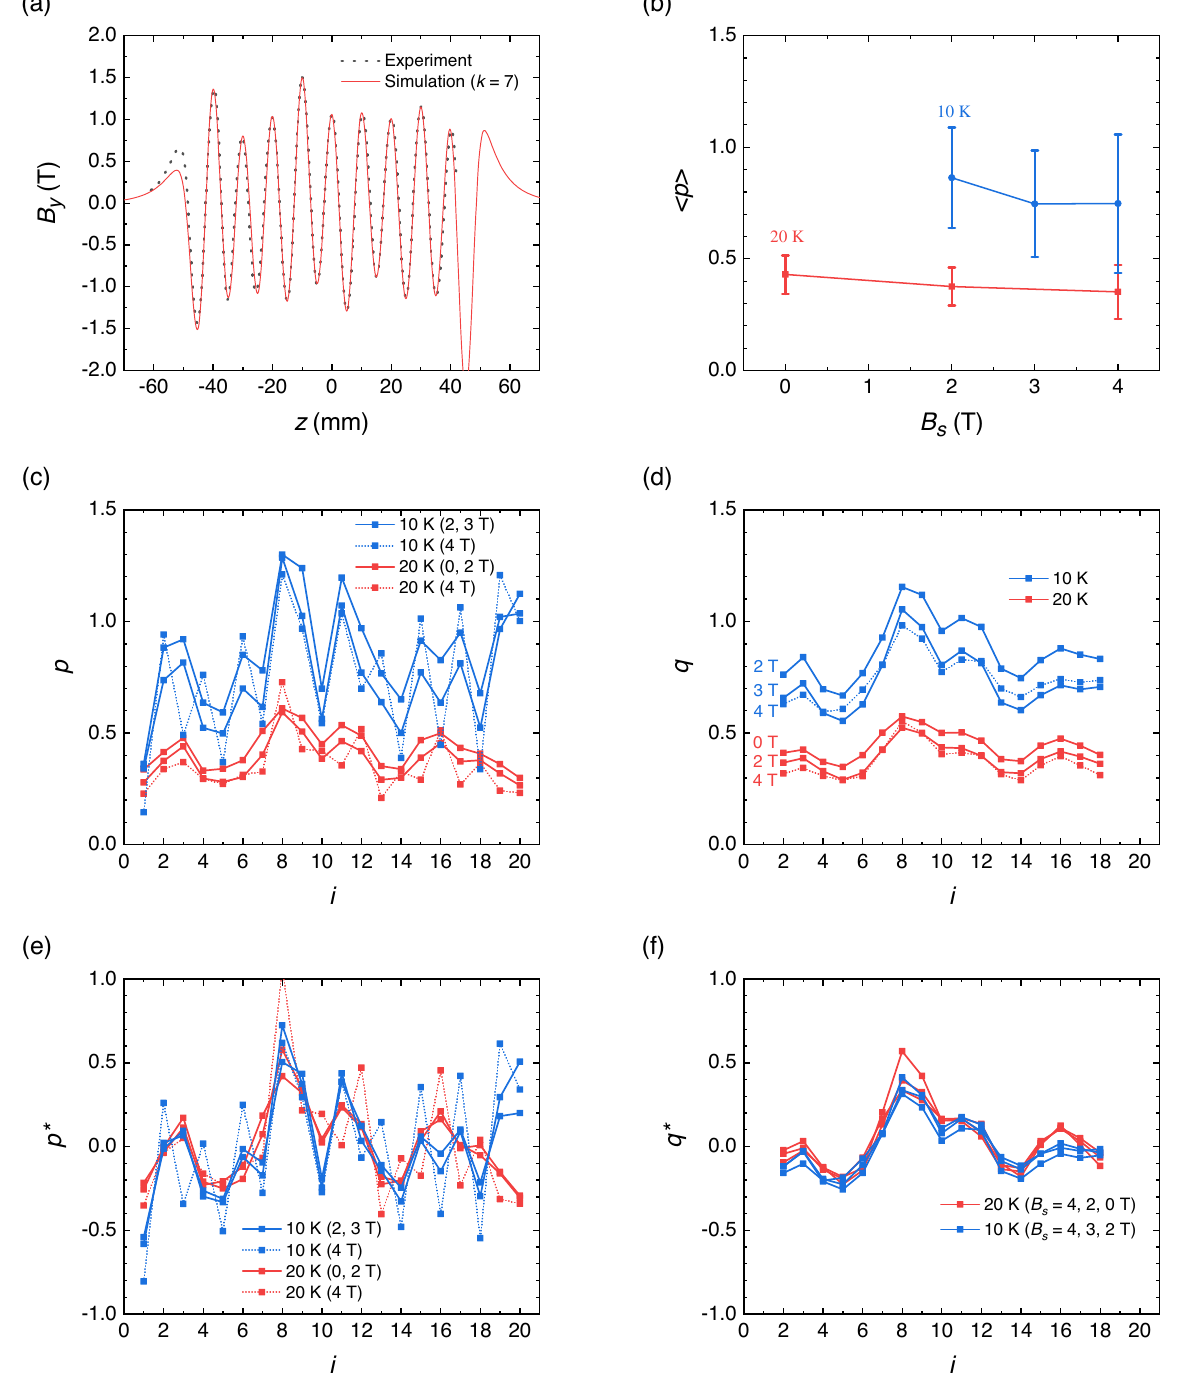
, (b) the average and the standard deviation of the y